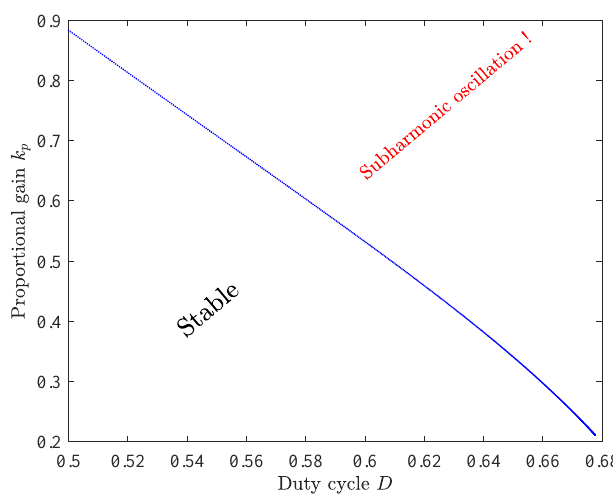
Figure 7. Stability boundaries in terms of the proportional gain k p and the quasi-steady-state duty cycle D and for V M = 2 V.